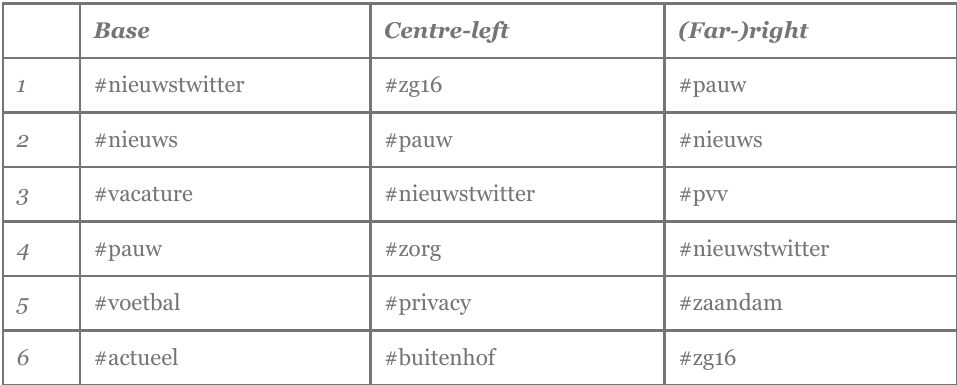
Fig. 4. Distribution of top six hashtags across clusters/entire graph. Base Centre-left